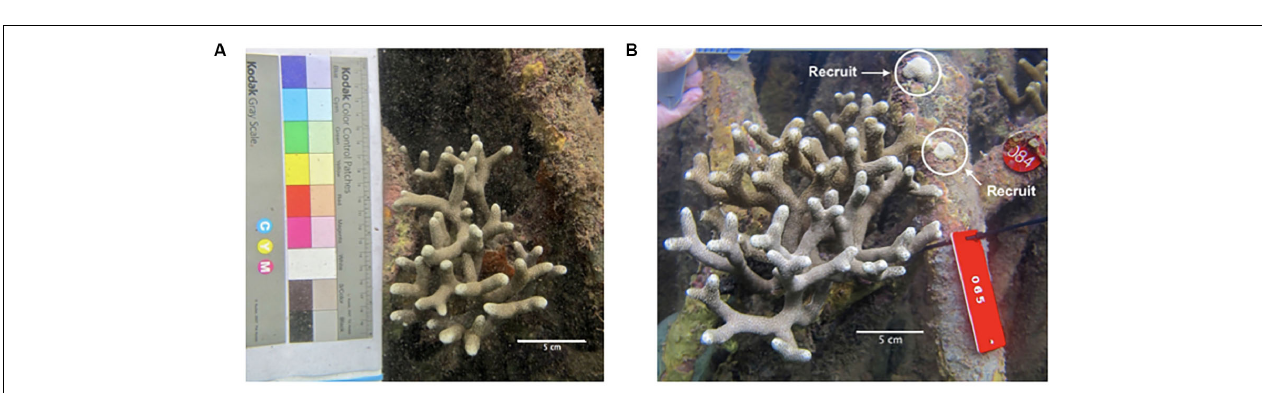
FIGURE 9 | Sensitivity and elasticity analyses. The sensitivity and elasticity of the integral projection model in 2015–2016 (A,B) and 2016–2017 (C,D) are plotted relative to colony size. In all graphs, colony size was plotted as ln(ecological volume). As described in the methods, all recruits were assumed to enter the population below the smallest size class [ln(ecological volume) < –4]. Areas on the plot exhibiting higher sensitivity and elasticity values, which indicates a greater contribution to λ , are associated with recruits (indicated by arrows) and with individuals of larger sizes for both years.